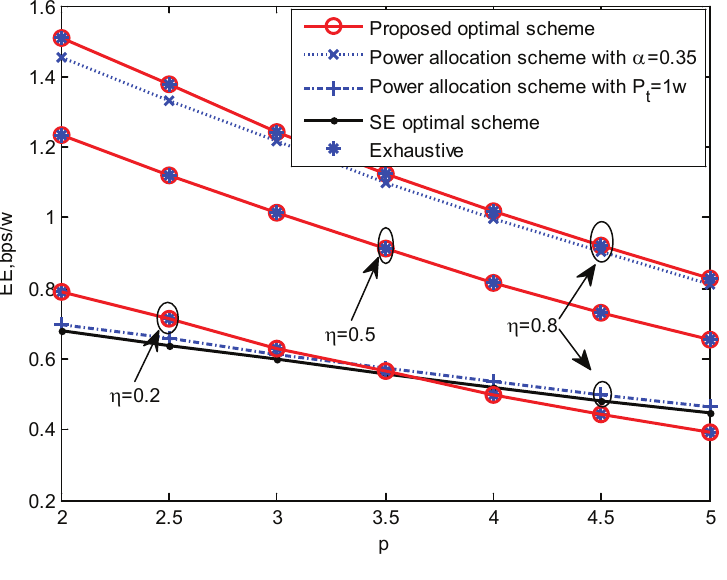
Figure 5. EE versus the path loss